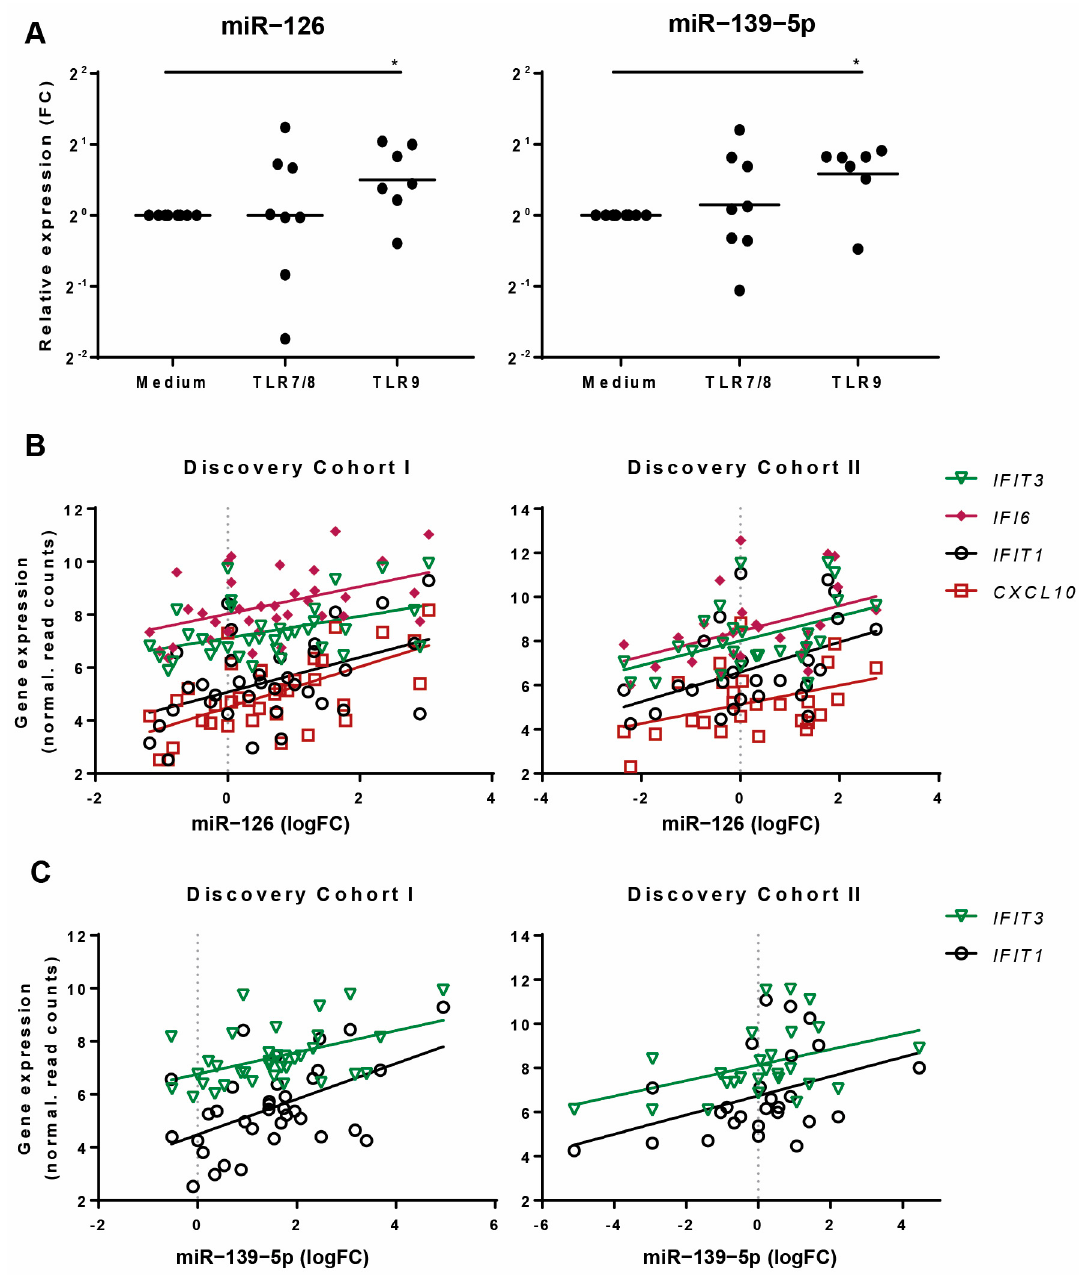
Figure 4. TLR9 stimulation upregulates miR-126 and miR-139-5p expression. ( A ) PDCs from seven to eight independent healthy donors ( n = 7–8) were stimulated for 24 h with TLR7/8 and TLR9 ligands and the expression of miR-126 and miR-139-5p was assessed by specific qPCR assays. The expression is presented as Fold Change (FC) as compared to the mean expression of the control medium group. Data were normalized to U6 snRNA expression and presented as geometric mean (mid-line) ( p < 0.05, Wilcoxon signed-rank test to compare each sample to its paired unstimulated condition). * indicates p -value < 0.05. ( B ) Correlation of miR-126 with IFN-responsive genes as measured by RNA sequencing in discovery cohort I and II (discovery cohort I: IFTIT3 r = 0.378 p = 0.025, IFI6 r = 0.468 p = 0.005, IFIT1 r = 0.397 p = 0.018 and CXCL10 r = 0.558 p = 0.0005 and discovery cohort II; IFTIT3 r = 0.444 p = 0.023, IFI6 r = 0.482 p = 0.013, IFIT1 r = 0.471 p = 0.015 and CXCL10 r = 0.397 p = 0.045) and ( C ) Correlation of miR-139-5p with IFN-responsive genes as measured by RNA sequencing in discovery cohort I and II (discovery cohort I: IFIT3 r = 0.403 p = 0.016, IFIT1 r = 0.436 p = 0.009 and discovery cohort II IFIT3 r = 0.411 p = 0.037, IFIT1 r = 0.416 p = 0.034). Only IFN genes significantly correlated in both cohorts are reported in B , C (Spearman’s correlation p < 0.05).